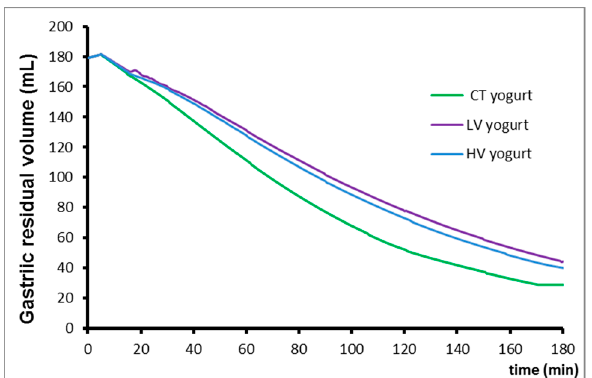
Figure 1. Gastric residual volume for the three yogurts. CT, LV, HV stand for control, low viscosity and high viscosity yogurts, respectively. T 1/2 means gastric emptying half-time.